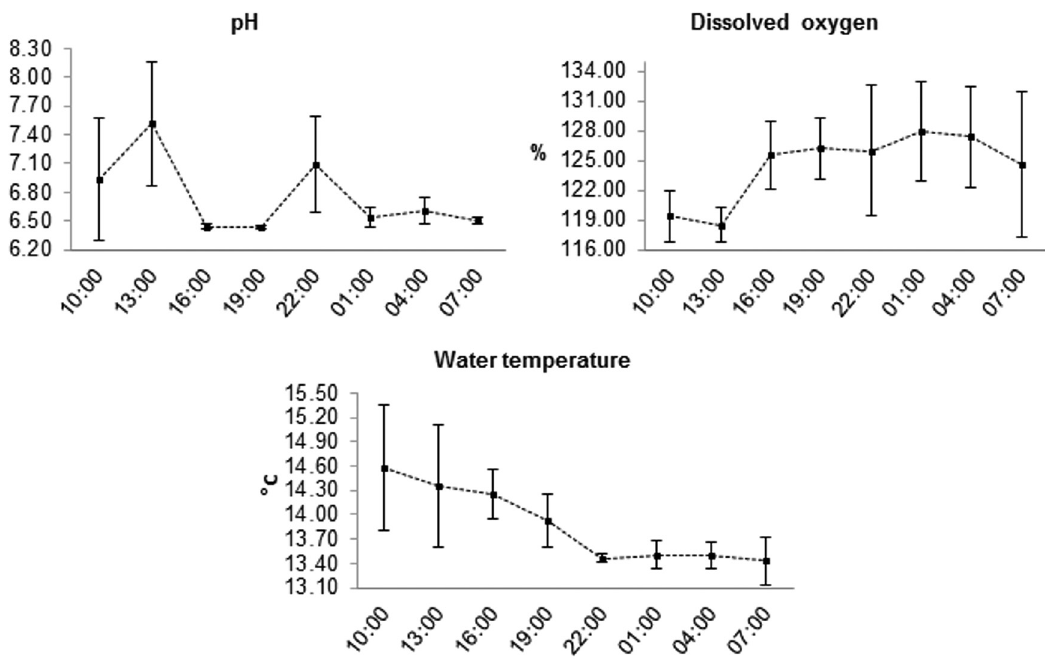
Figure 2. Average daily variation and standard deviation of pH, dissolved oxygen (%) and water temperature (°C) in the trout farming system, considering the three sectors of